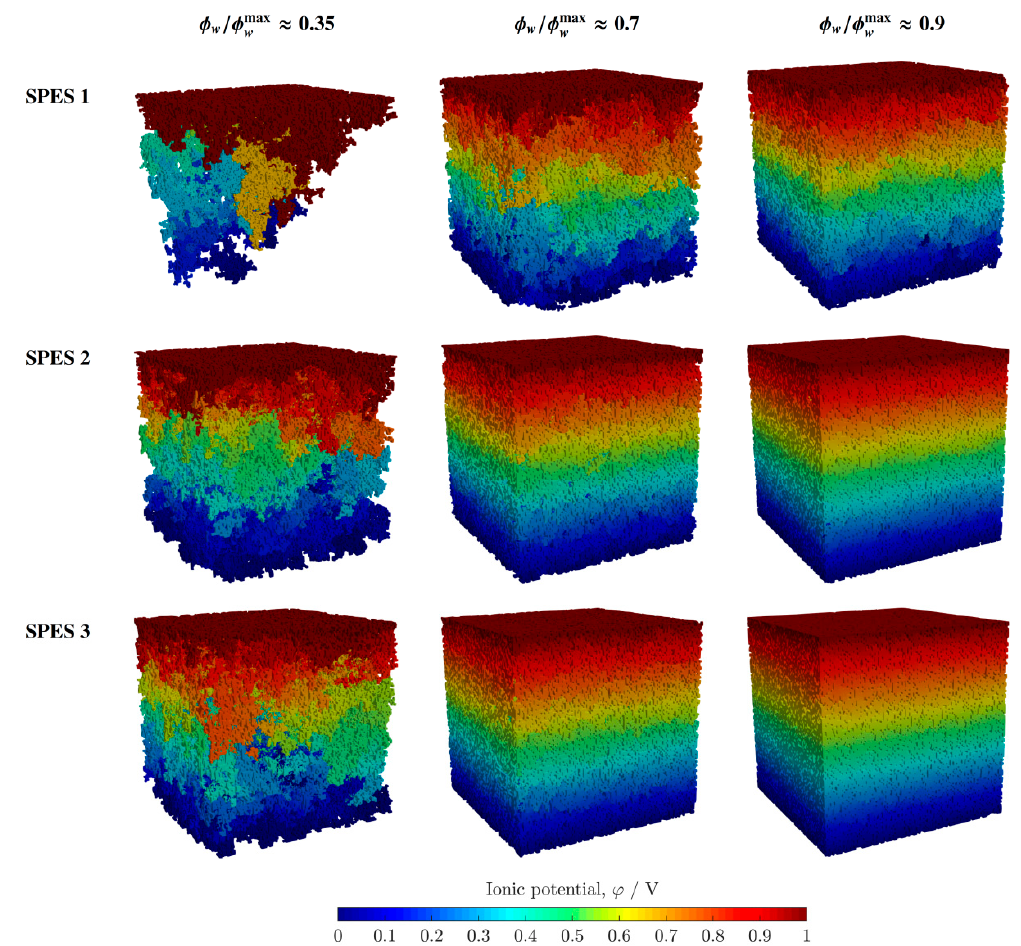
Figure 7. Computed ionic potential distributions corresponding to the SPES membranes and three different relative volume fractions of hydrated sites, 𝜙 (cid:3050)(cid:3045) /𝜙 (cid:3050)(cid:3045)(cid:2923)(cid:2911)(cid:2934) (≃ RH) ≈ 0.35, 0.7,and 0.9.